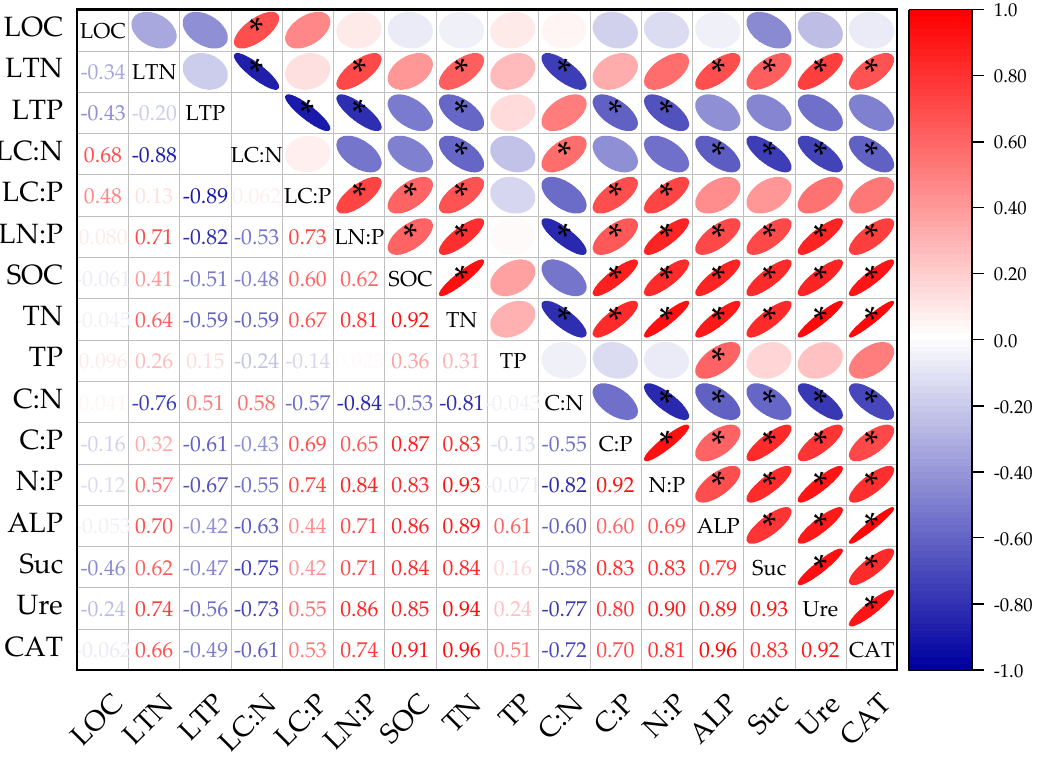
Figure 5. The correlation analysis of the nutrient and stoichiometric ratios and soil enzyme activity of litter − soil. Note: SOC, soil organic carbon content (g/kg); TN, soil total nitrogen content (g/kg); TP, soil total phosphorus content (g/kg); LOC, litter carbon content (g/kg); LTN, litter total nitrogen content (g/kg); LTP, litter total phosphorus content (g/kg); C:N, soil C:N ratio; C:P, soil C:P ratio; N:P, soil N:P ratio; LC:N, litter C:N ratio; LC:P, litter C:P ratio; LN:P, litter N:P ratio. * indicates that the correlation was significant at p < 0.05.